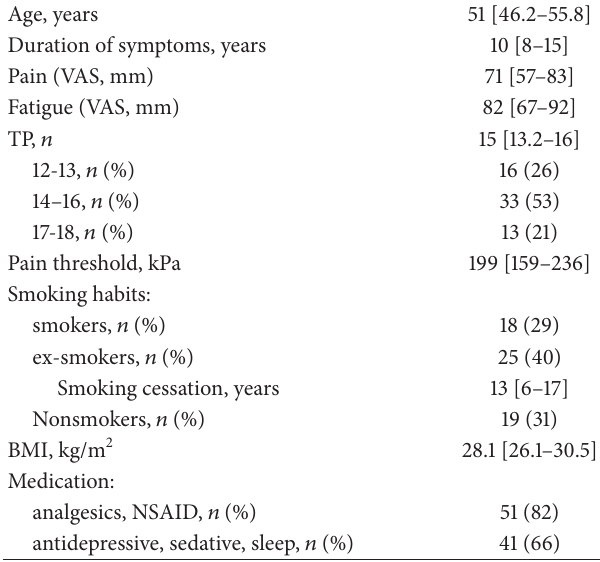
Table 1: Clinical and demographic characteristics of patients with fibromyalgia (𝑛 = 62)